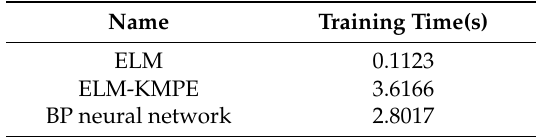
Table 2. Training time of ELM, ELM-KMPE, and BP neural network.